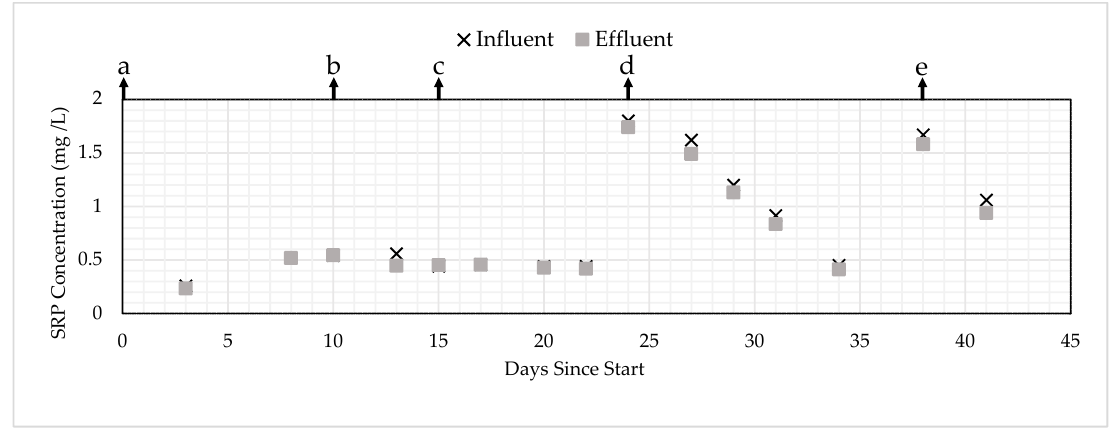
Figure 7. SRP removal for the SFS under changing initial concentrations and EBCTs/HRTs.